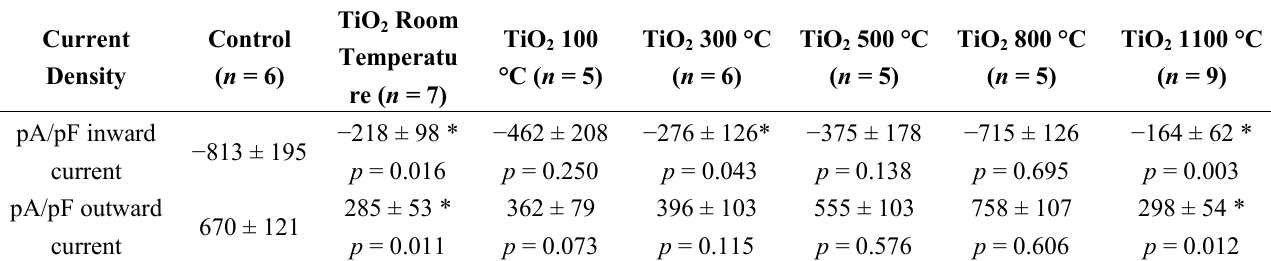
Table 2. Inward and outward current density in DRG neurons cultured in the control substrate and TiO thin films surfaces prepared at room temperature and annealed at 2 temperatures between 100 and 1100 °C.